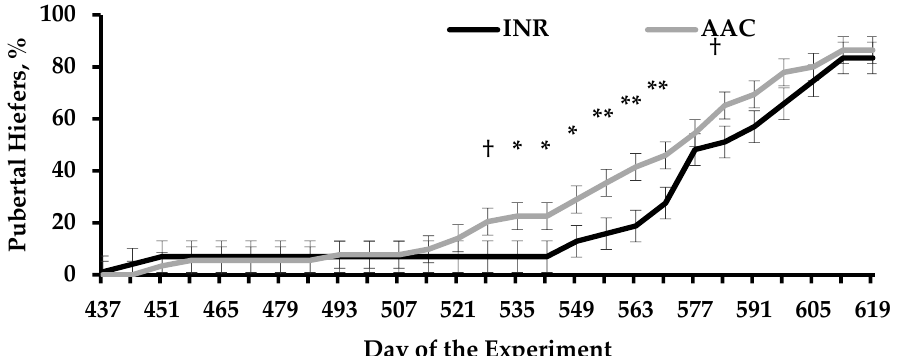
Figure 1. Puberty attainment of replacement heifers from beef cows that received diets containing supplemental sulfate sources of Co, Cu, Mn, and Zn (INR) or organic-complexed source of Co, Cu, Mn, and Zn (AAC) during gestation. Adapted from Harvey et al. [85]. Heifers were weaned on d 367 of the experiment, at ~7 mo of age. A treatment × day interaction was detected ( p < 0.01). Within days: † 0.05 ≤ p ≤ 0.10; * p ≤ 0.05; ** p < 0.01. Table 5. Productive responses and mRNA expression of longissimus muscle genes in replacement heifers born from beef cows that received diets containing supplemental sulfate sources of Co, Cu, Mn, and Zn (INR) or organic complexed source of Co, Cu, Mn, and Zn (AAC) during gestation 1 . Item Initial body weight 2 , kg Final body weight 2 , kg Average daily gain 2 , kg/d Final puberty attainment 3 , %